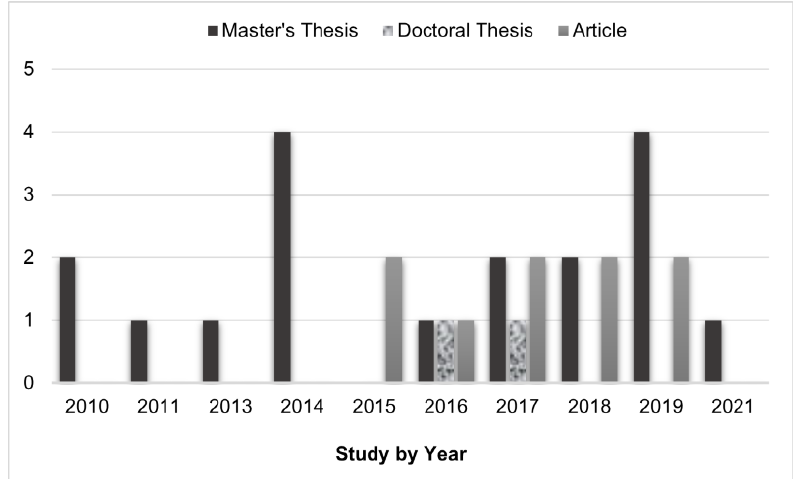
Figure 2: Distribution of Studies by